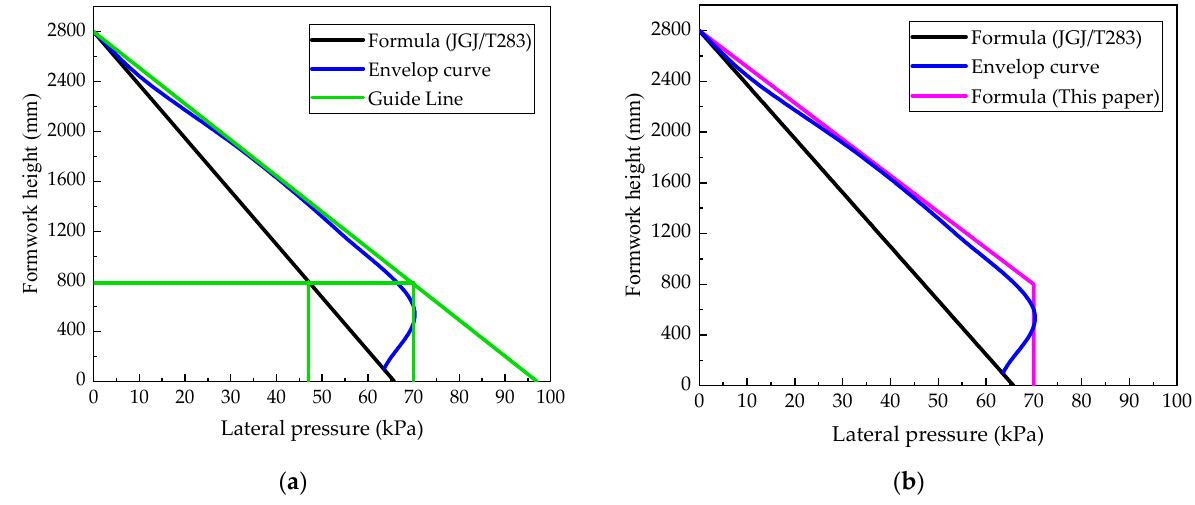
Figure 5. Formula derivation: ( a ) comparison of calculated results; ( b ) Equation